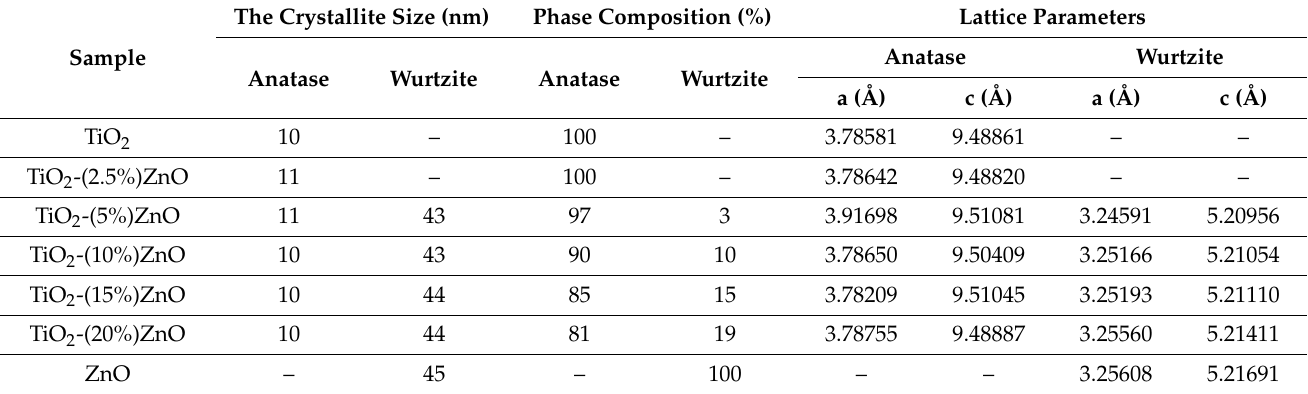
Table 2. The average crystallite size and phase composition of the obtained TiO 2 -ZnO systems and references samples.